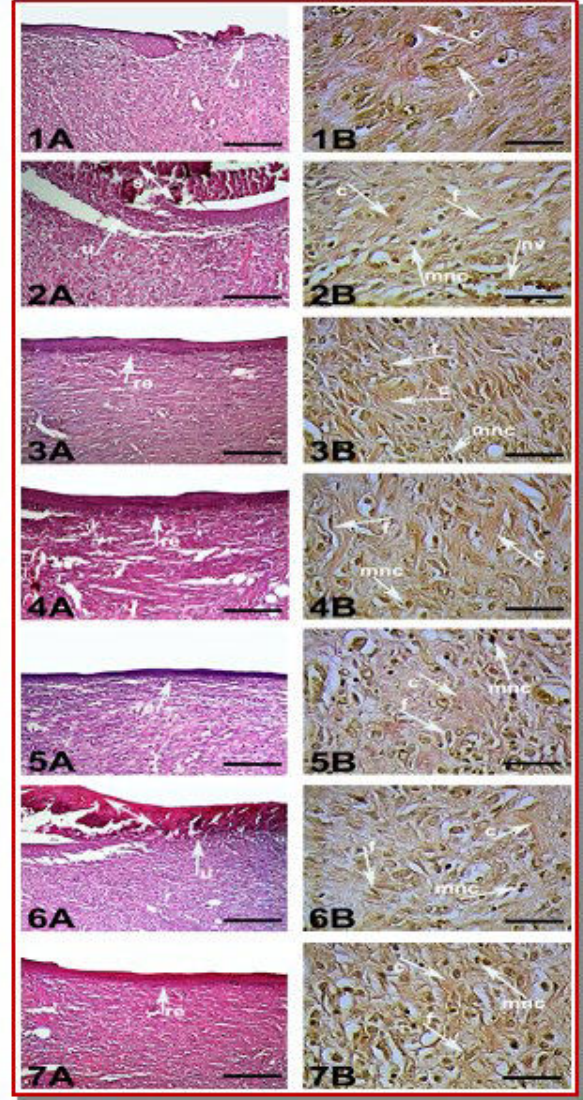
Figure 1: Histopathological view of wound healing and epi- dermal/dermal re-modeling in the test material administered animals. Skin sections show the hematoxylin & eosin (HE) stained epidermis and dermis in A, and the dermis stained with Van Gieson (VG) in B. The original magnification was x100 and the scale bars represent 120 µm for figures in A, and the original magnification was x400 and the scale bars represent 40 µm for B. Data are representative of 6 animal per group. 1) Vehicle group, 2) Negative Control group, 3) A. mollis AE, 4) A. mollis R; 5) A. persica AE, 6) A. persica R, 7) Madecassol ®. Arrows pointing events during wound healing; s: Scab, u: Ulcus, re: